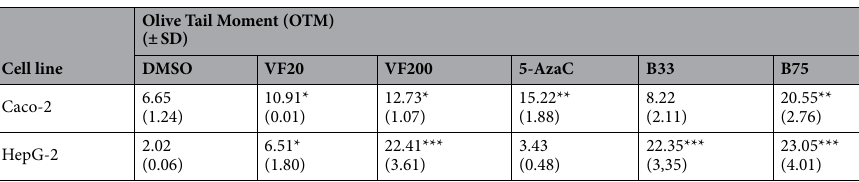
Table 3. Values of OTM (averages) obtained by Comet assay (± Standard Deviation of two independent experiments) expressing the DNA damage inducing power of (±)- trans -δ-viniferin on both treated cell lines. (*) 0.05 < p < 0.01; (**) 0.01 < p < 0.005; (***) p < 0.001, calculated with the χ 2 test in comparison with respective DMSO- treated cells